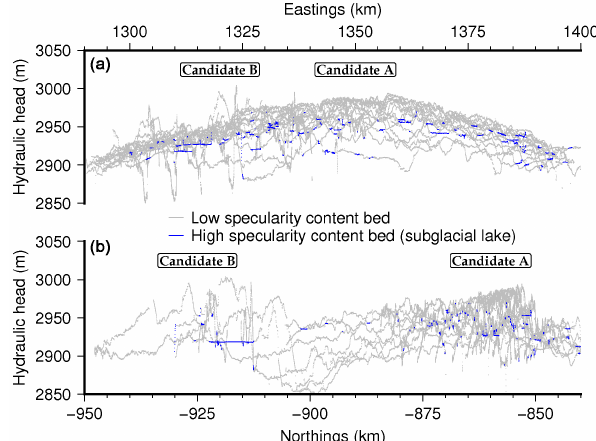
Figure 4. The OIA extracted bed data projected into the hydraulic head (the water level equivalent to the pressure imposed by the ice overburden), and viewed in the projected northing plane ( b , look- ing across the ice divide) and projected easting plane ( a , looking along the ice divide). Regions of high specularity content (sub- glacial lakes) are highlighted in blue. Note that lakes are flat, in- dicating hydrostatic equilibrium. Many of the subglacial lakes lie in valleys that cut into the primary surface that envelopes the local sub- glacial topography; only one is found above the 2950m head level. Projection for the horizontal axis eastings and northings is Antarctic Polar